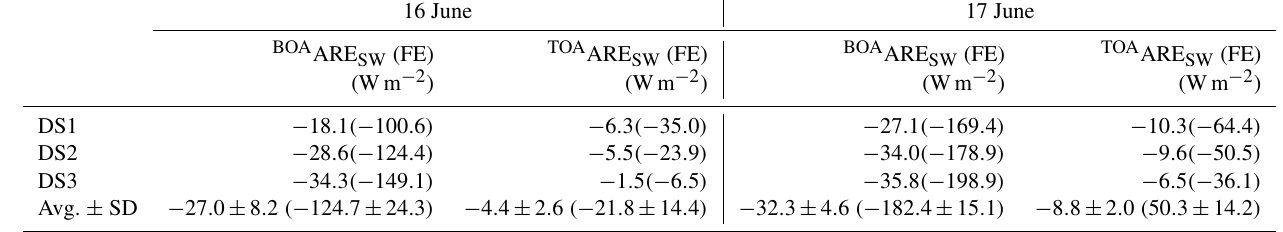
Table 6. ARE (and FE indicated between parenthesis) at the BOA and the TOA for the SW spectral range obtained with GAME using as inputs DS1, DS2, and DS3 for 16 and 17 June 2013. The averaged values and standard deviation are also included.